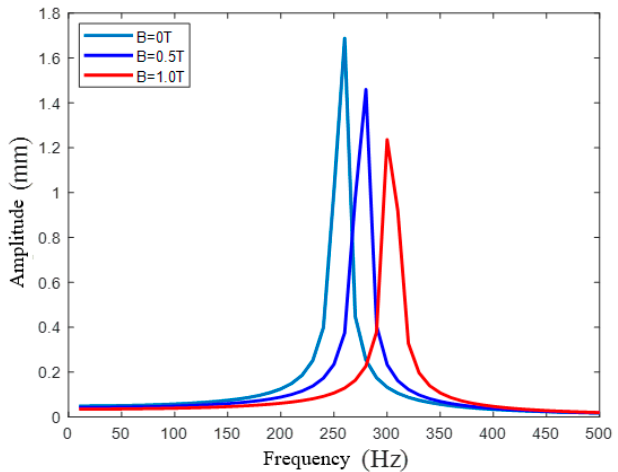
Table 4. Natural frequency under different magnetic fields.